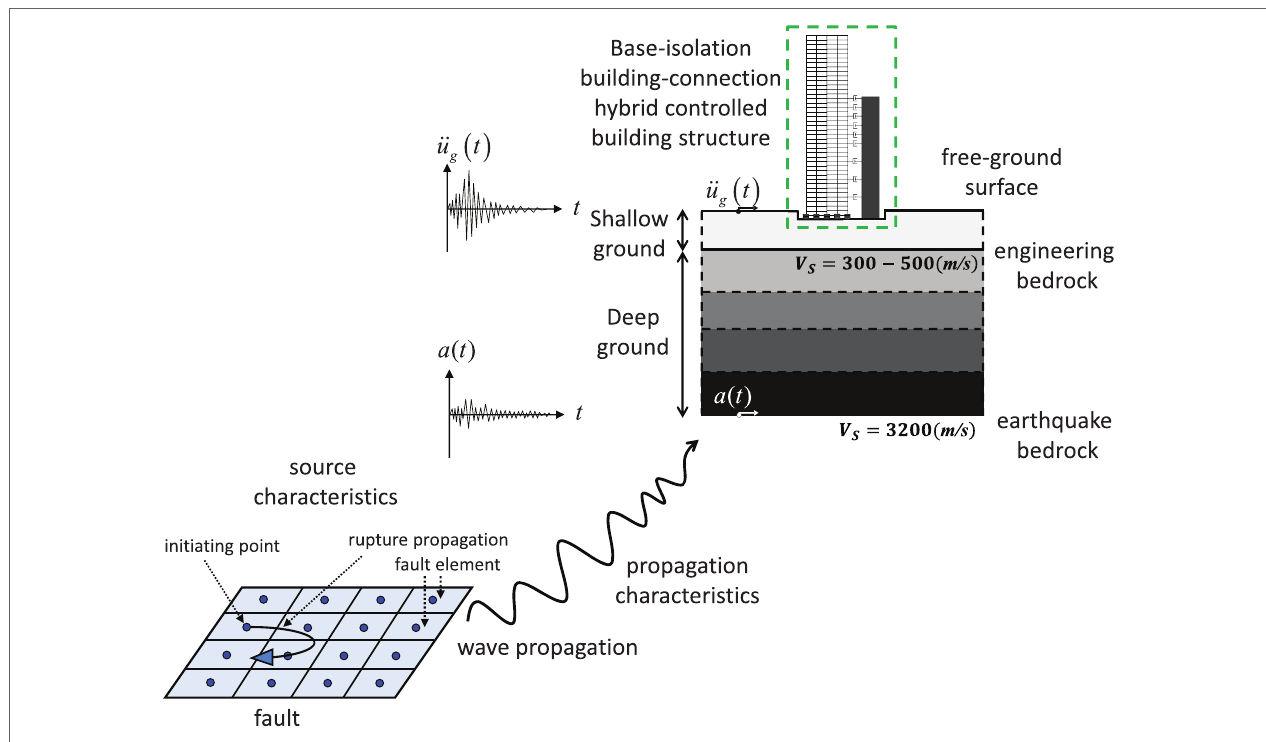
FIGURE 1 | Schematic diagram of a scenario for evaluating the response of a base-isolation building-connection hybrid controlled structure taking into account the fault rupture, wave propagation, and ground-motion amplification in deep ground.